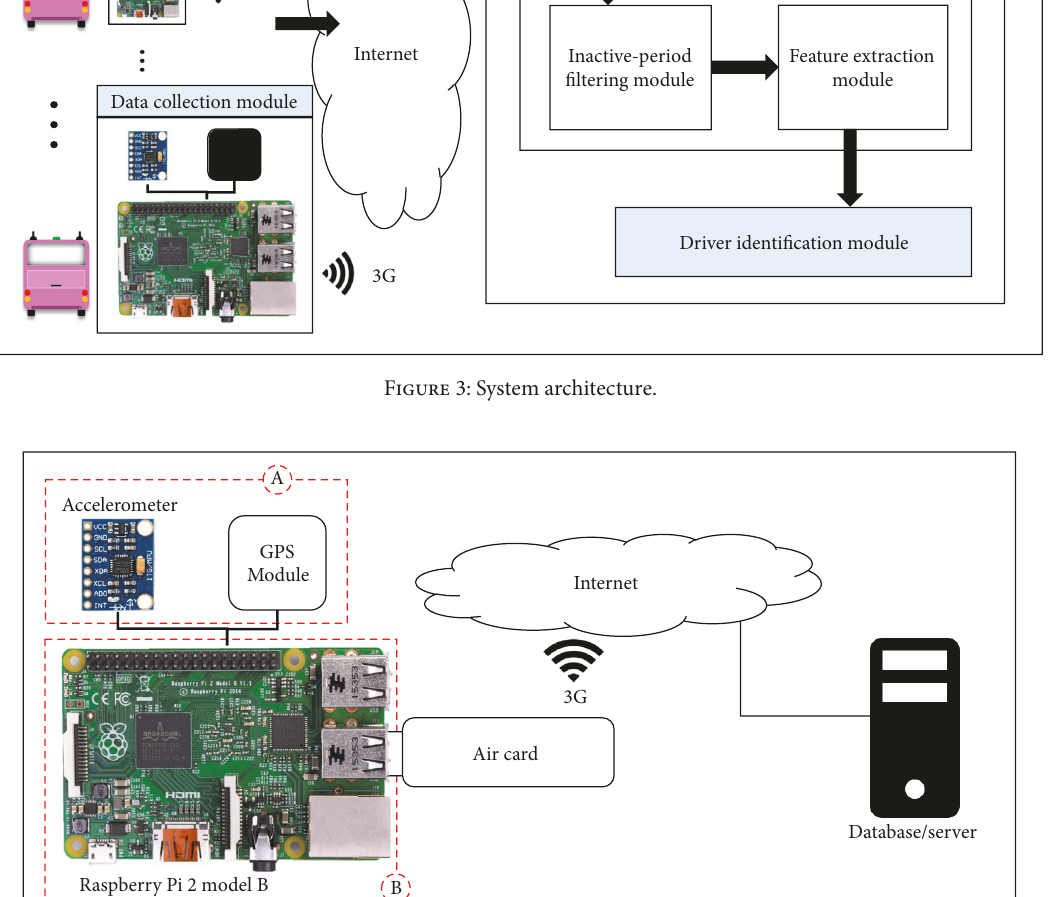
Figure 4: The data collection module, where A is a data producing part and B is a data processing